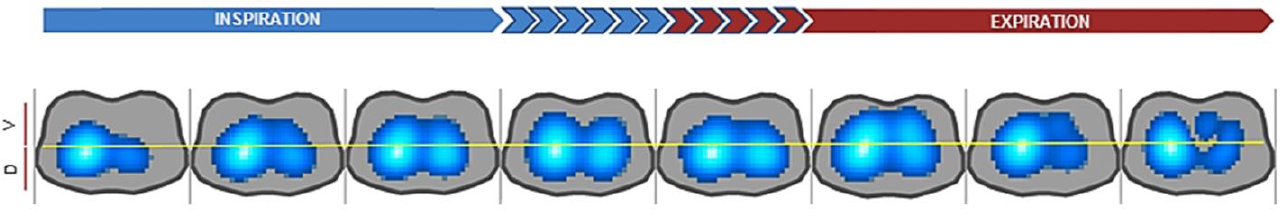
Figure 2. Sequence of electrical impedance tomography images, representing the distribution of ventilation in the ventral (V) and dorsal (D) regions during quiet breathing (Enlight 1800, Timpel SA, San Paulo, Brazil). The gradation of color from lighter to darker represents, respectively, the highest and lowest electrical impedance (higher and lower air displacement during the cycle). Cour- tesy of Caio CA Morais and Armele Dornelas de Andrade (Physiotherapy Department, Univer- sidade Federal de Pernambuco, Recife, Brazil).